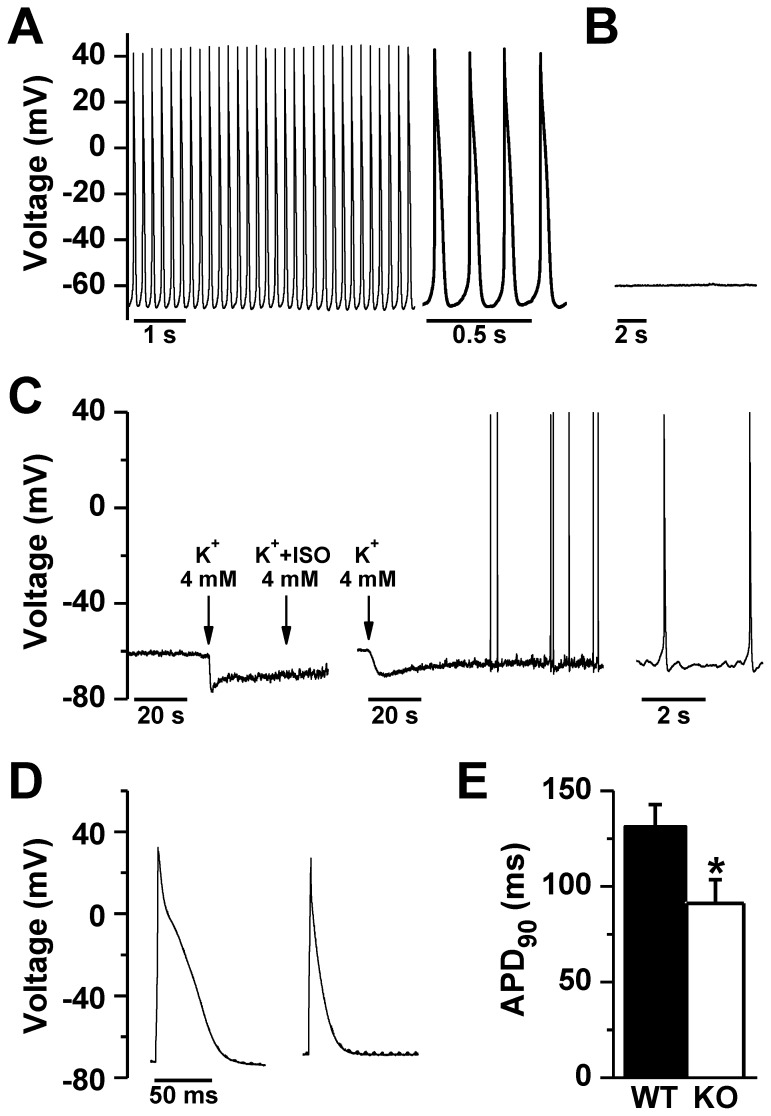
Action potentials in WT and NCX1 KO SAN cells.Spontaneous action potentials occurred at regular intervals in patch clamped WT SAN cells (A), but were absent in NCX1 KO SAN cells (B). C. In KO cells, lowering diastolic membrane potential by reducing bath K to 4 mM (arrow) sometimes elicited spontaneous APs. This only occurred 4 out of 7 times, even when isoproterenol (ISO) was added; two examples are shown, with the time scale expanded on the far right. D. WT (left) and quiescent NCX1 KO SAN cells (right) could be paced in current clamp mode. Note the reduced AP duration at 90% repolarization (APD90) compared to WT cells, summarized in panel E (*P<0.05 by t-test).